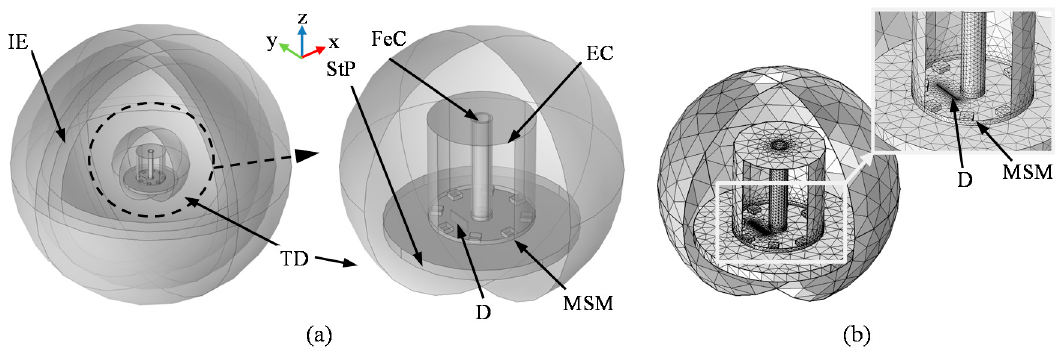
Figure 4. Utilized FEM model of the transducer: IE—infinite element domain, TD—transducer’s domain, StP—steel plate, MSM—multi-sensor matrix, FeC—ferrite core, EC—excitation coil, D—defect; ( a ) model view, ( b ) computation mesh view.